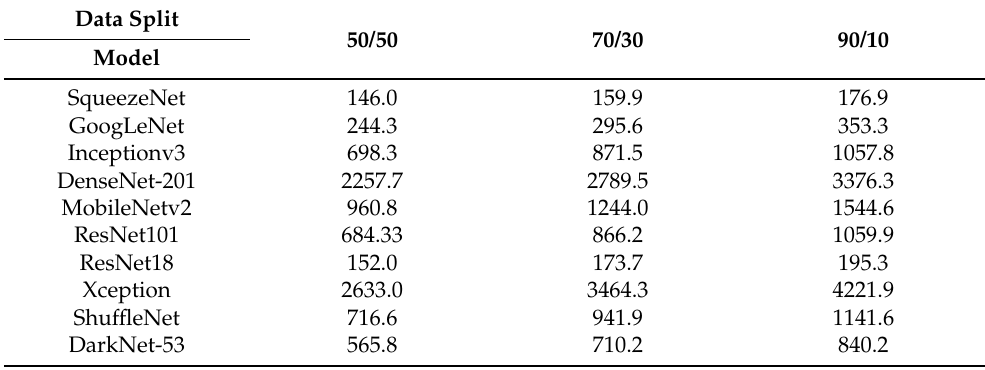
Figure 7. A sample of correctly classified images along with the class probability. Table 5. The mean training and validation times for all algorithms and all data split strategies. All times are in seconds.